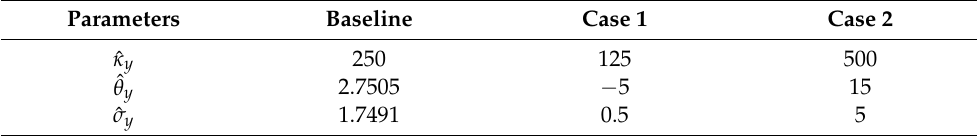
Table 3. Estimation associated with Kim’s model for the SEV-4/2